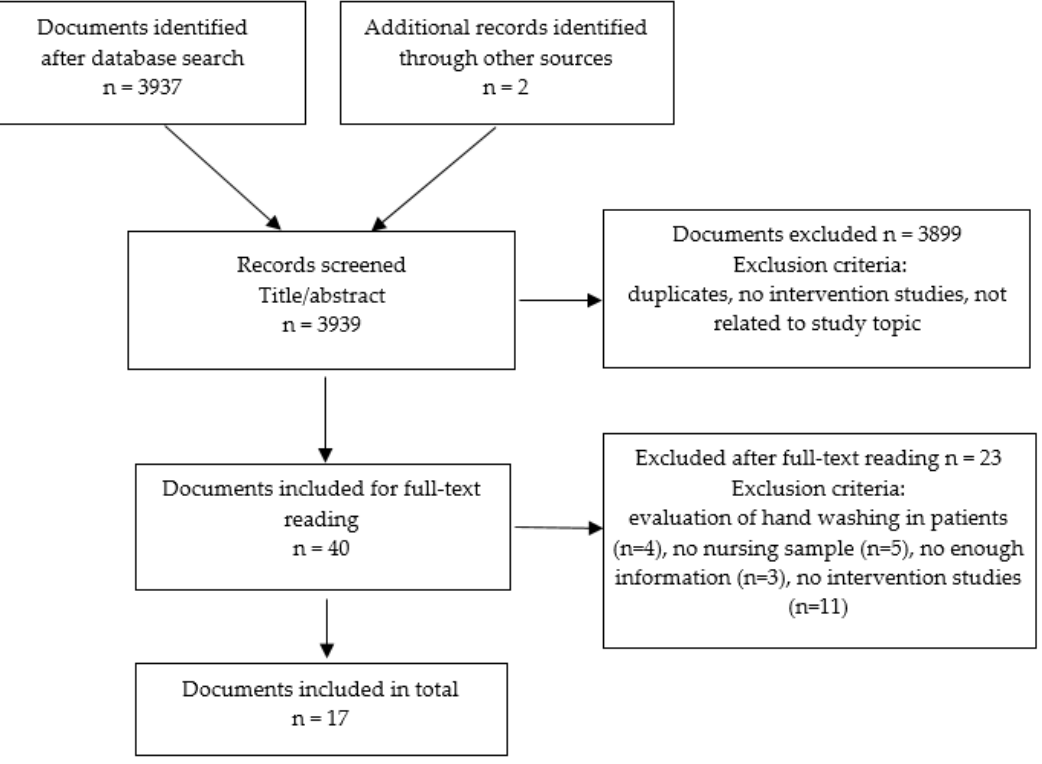
Figure 1. Flow chart of included studies.